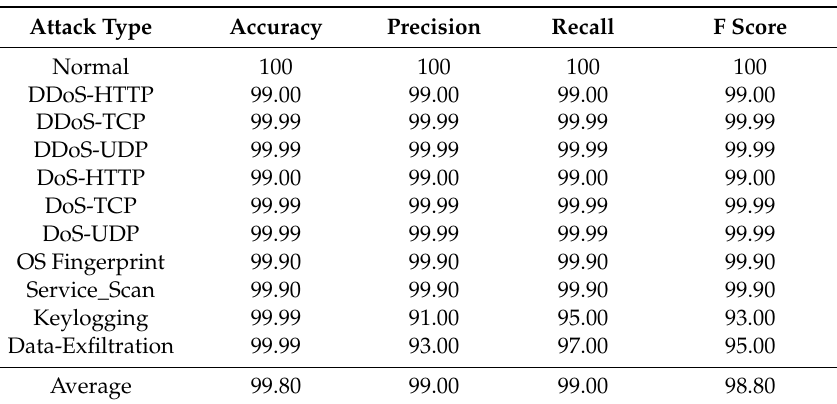
Table 10. Accuracy, Precision, Recall, and F Score for